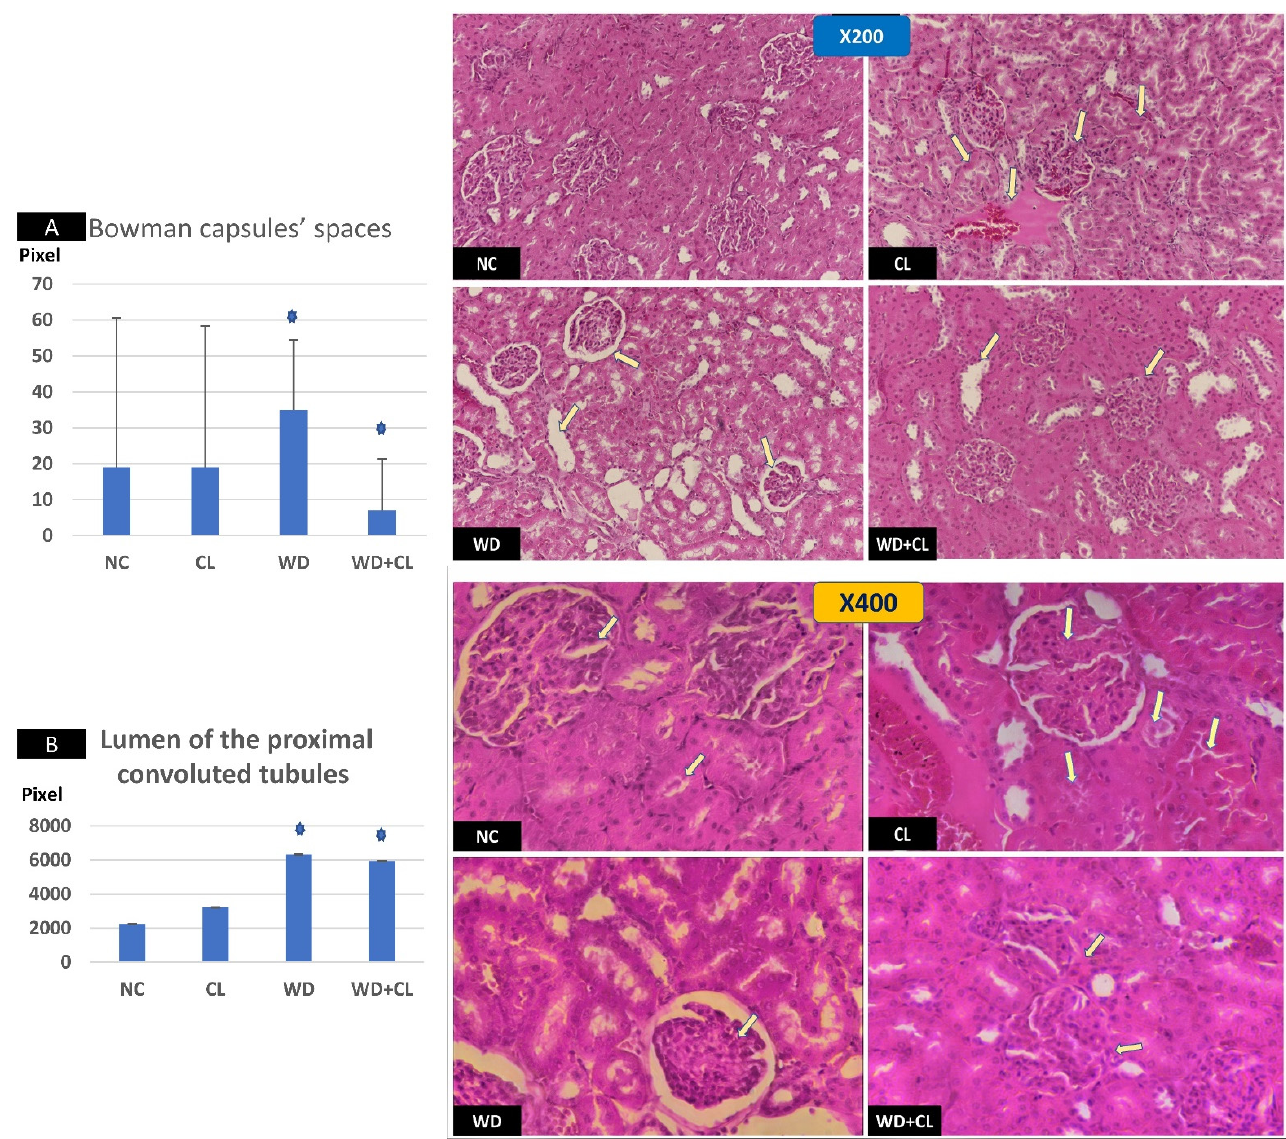
Figure 5. Sections in the renal cortex at ×200 (above) and ×400 (below). The normal control (NC) section shows normal glomeruli. Continuous light (CL) shows a thick glomerular membrane with the cloudy swelling of proximal convoluted tubules (PCT) in form of the increased size of lining epithelium, cloudy cytoplasm, and star-shaped lumen (arrows). Western diet (WD) slide shows inflammatory and hypertrophic changes in the glomeruli with increased Bowman capsular space (arrows). Combined WD + CL shows the disappearance of Bowman capsule spaces with mild inflammatory cell infiltration (arrows). Image J tool measurements showed a significant dilatation of Bowman capsule spaces in the WD group and significant narrowing in the WD + CL ( A ). The lumen of the PCT showed progressive dilatation, especially the WD and WD + CL groups ( B ). * p < 0.05.